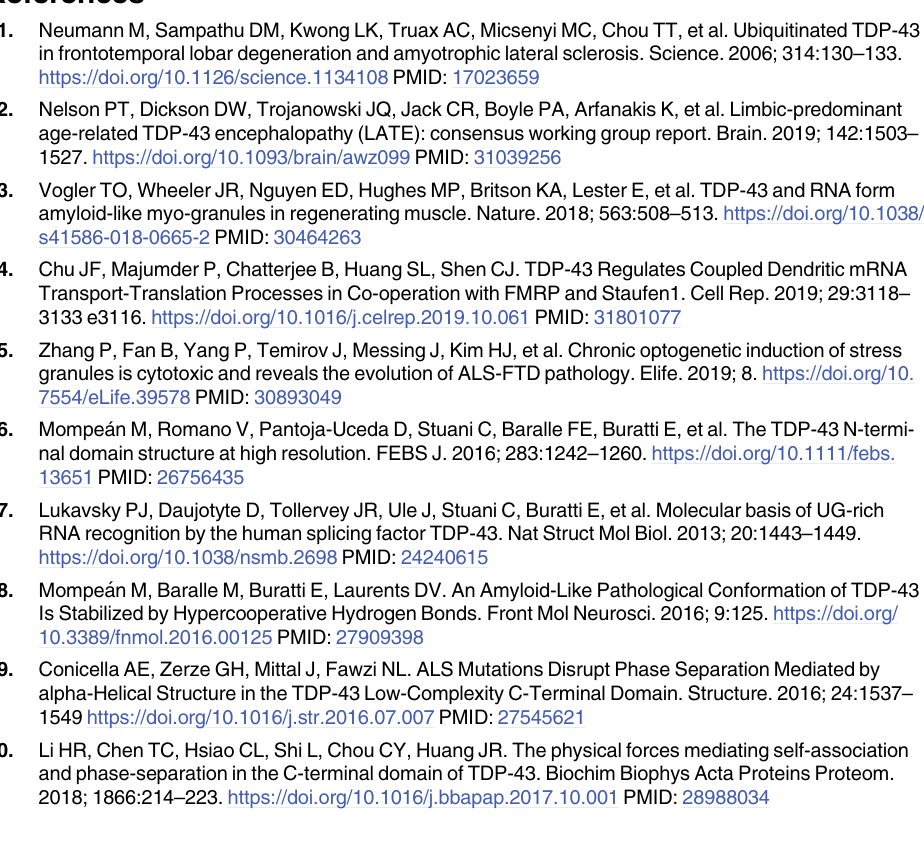
S1 Data. Numerical data for Figs 1, 2 and